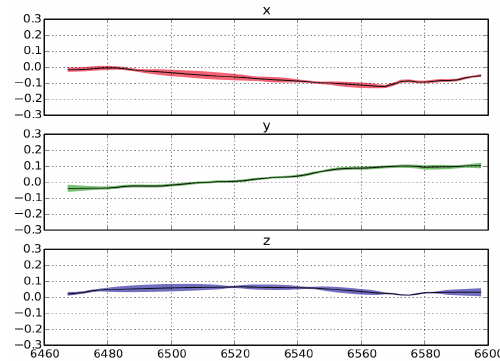
Figure 9. Adjustment result for the anchor points between linear position 6470 m and 6600 m with bounded variations in local neighbourhood (see Eq. 3). In each curve, the central line is the estimated value, where the band indicates the interval of one standard